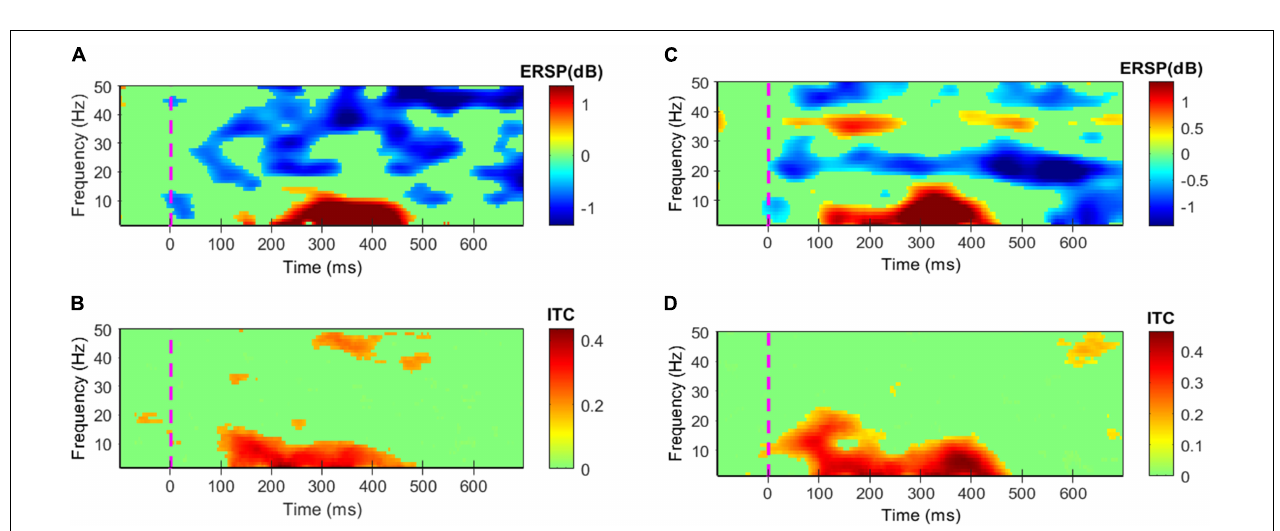
FIGURE 3 | Individual difference ERPs at the Cz electrode for six patients. Results of only first six patients have been shown to prevent over-burdening the figure, while we got similar outcomes for each of the 13 patients, which can also be deduced from the SD shape exhibited in Figure 2A .